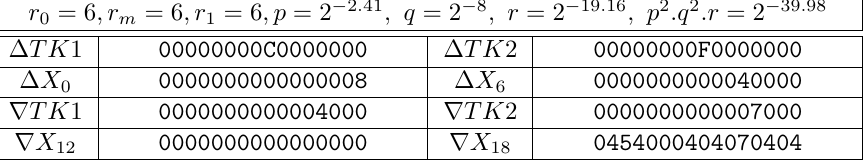
Table 9: Specification of boomerang distinguisher I for 18 rounds of SKINNY